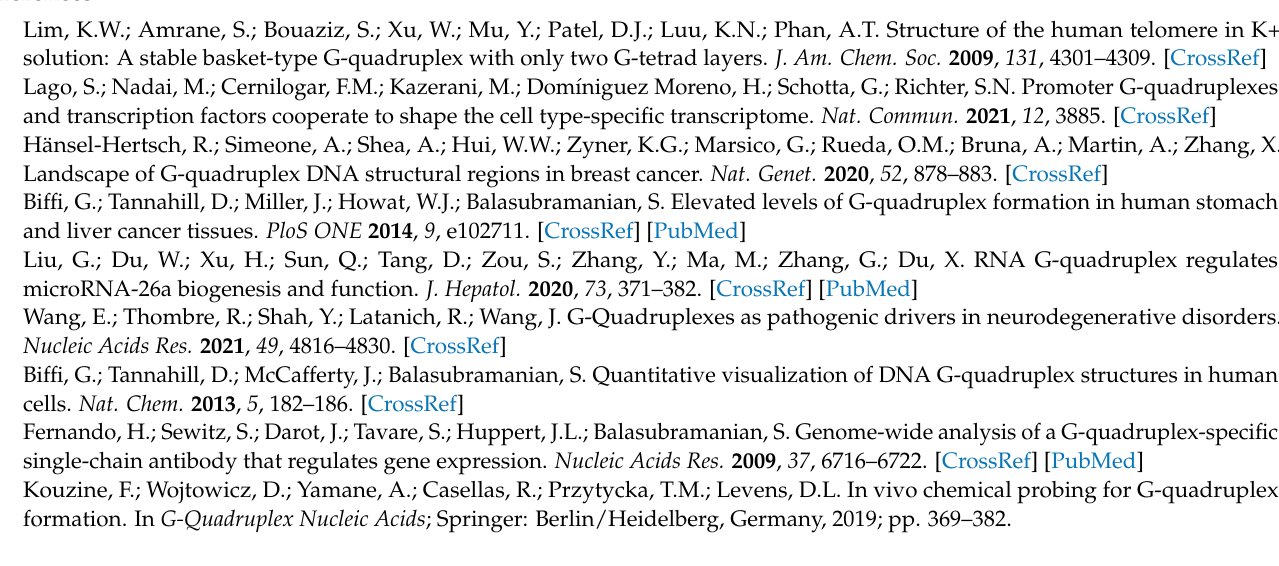
Family 4; Figure S2: Top 25 GO:BP enrichments for Family 32; Figure S3: Top 25 GO:BP enrichments for Family 74; Figure S4: Top 25 GO:CC enrichments for Family 80; Figure S5: Top 25 GO:BP enrich- ments for experimentally validated G4s overlapping enhancers, group 1; Figure S6: Correlation of selected enhancers consisting of pG4 with gene expression in multiple cell types utilizing the epimap correlation group-link data; Figure S7: Top 25 GO:BP enrichments for experimentally validated G4s overlapping enhancers, group 2; Table S1: Summary of Family 23; Table S2: Summary of Family 79 G4 sequences; Table S3: Sequence repeats capable of forming multiple G4 structures; Table S4: Summary of Family 2 G4 sequences; Table S5: Summary of Family 3 G4 sequences; Table S6: Summary of Family 4 G4 sequences; Table S7: Summary of Family 32 G4 sequences; Table S8: Summary of Family 75 G4 sequences; Table S9: Summary of Family 80 G4 sequences; Table S10: Enriched GO:BP categories for Family 4; Table S11: Enriched GO:BP categories for Family 32; Table S12: Enriched GO:BP categories for Family 75; Table S13: Enriched GO:CC categories for Family 80; Table S14: Enriched GO:BP categories for experimentally validated G4s overlapping enhancers, group 1; Table S15: Enriched GO:BP categories for experimentally validated G4s overlapping enhancers, group